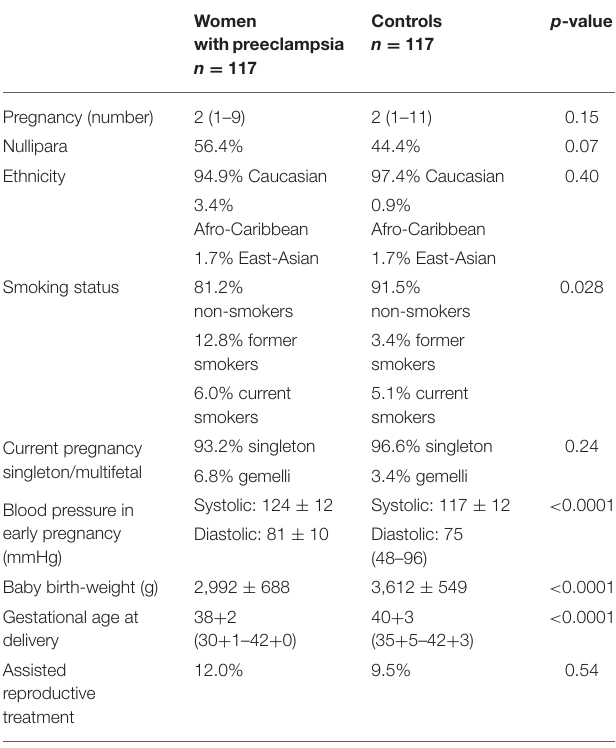
TABLE 1 | Matching criteria. TABLE 2 | Characteristics of the study